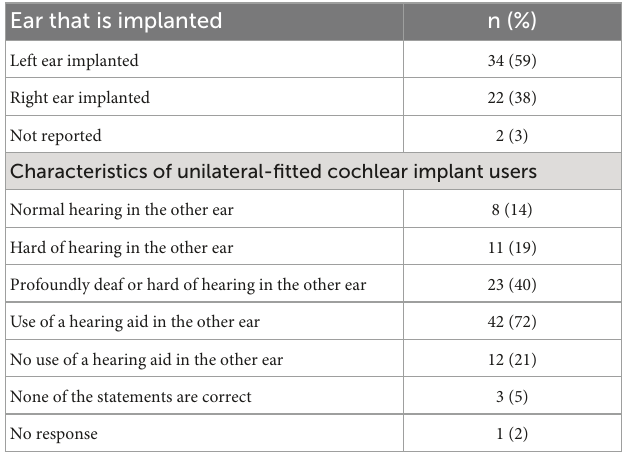
TABLE 2 Self-reported characteristics of the 58 participants that are fitted with a unilateral cochlear implant (CI) (23 participants were fitted